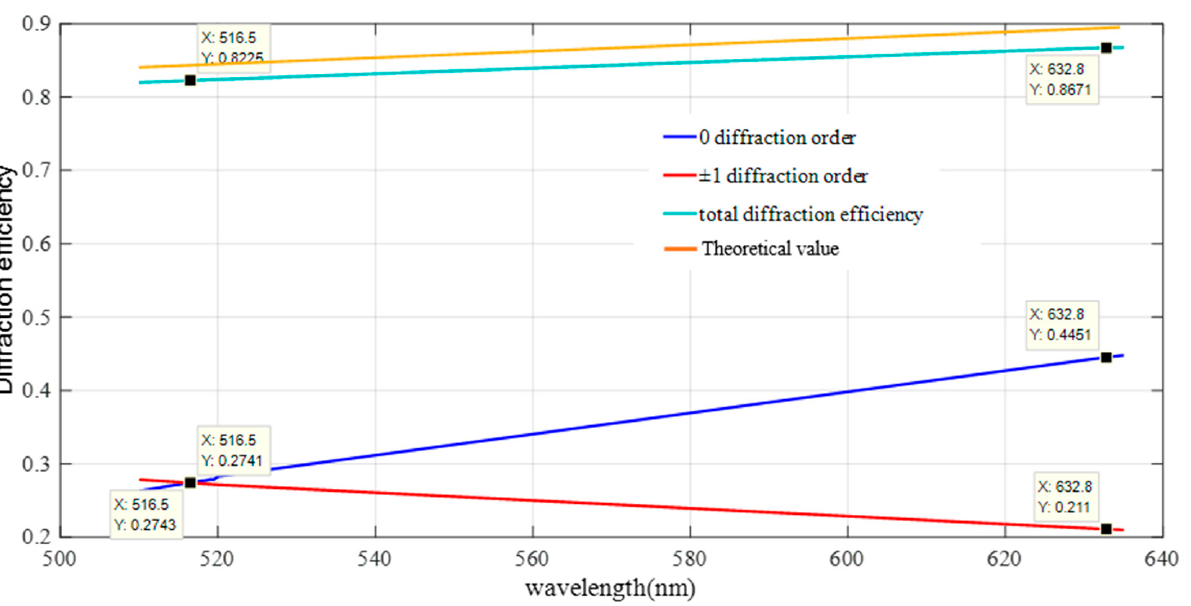
Figure 10. Inversion results of aberrated off-axis Fresnel wave with slice slot type test. The diffraction efficiency test optical system of the single wavelength (516.5 nm) ab-